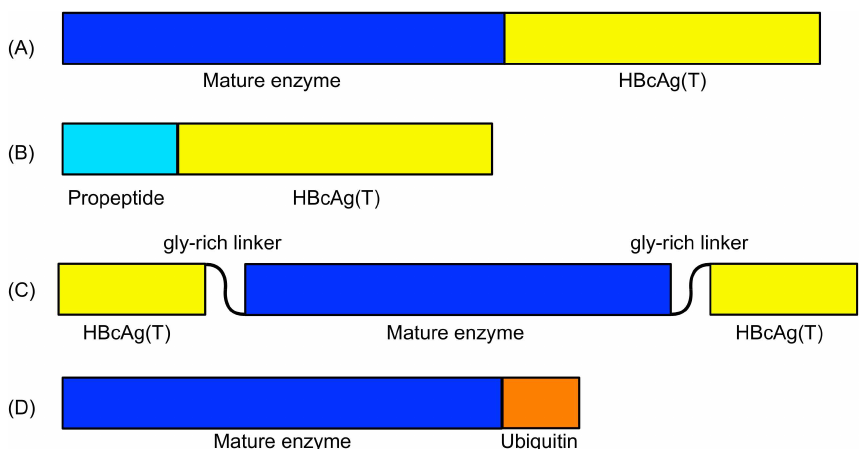
Fig 1. Schematic representation of the construct encoding fusion proteins. (A) mCPFhW::C construct consists of the sequenceencoding mature CPFhW (nt 319–976) ligatedto the 5’ end of the sequence encoding HBcAg(T) (nt 1903–2451). (B) pCPFhW::C construct consists of the sequenceencodingthe propeptideof CPFhW (nt 46–318)ligated to the 5’ end of the sequenceencodingHBcAg(T). (C) mCPFhW:: G::C construct consists of the sequenceencoding HBcAg(T) with an insertionencoding the mature CPFhW flankedby Gly-rich linkers ((Gly) 4 -Ser-(Gly) 4 -Gln-(Gly) 2 ). The mature CPFhW flanked at both ends by glycine residues is ligated betweennt 2120 and 2151 of the sequenceencoding HBcAg(T). (D) U::mCPFhW construct consists of a ubiquitinsequencespanning nt 767–995ligatedto the 5’ end of the sequence encoding mature